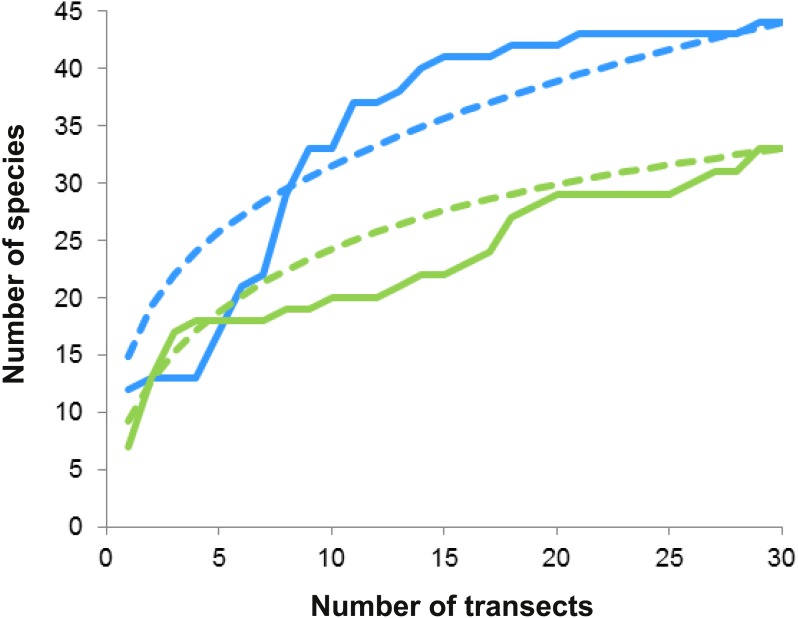
Species accumulation and rarefaction curves.Accumulation curves (continuous lines) and rarefaction curves (dashed lines) for macrocrustacean species recorded in Limones (green lines) and Bonanza (blue lines) reefs. Thirty belt transects, 50 m2 each, were sampled on each reef. Rarefaction curves for either reef do not reach an asymptote, indicating the existence of more species.